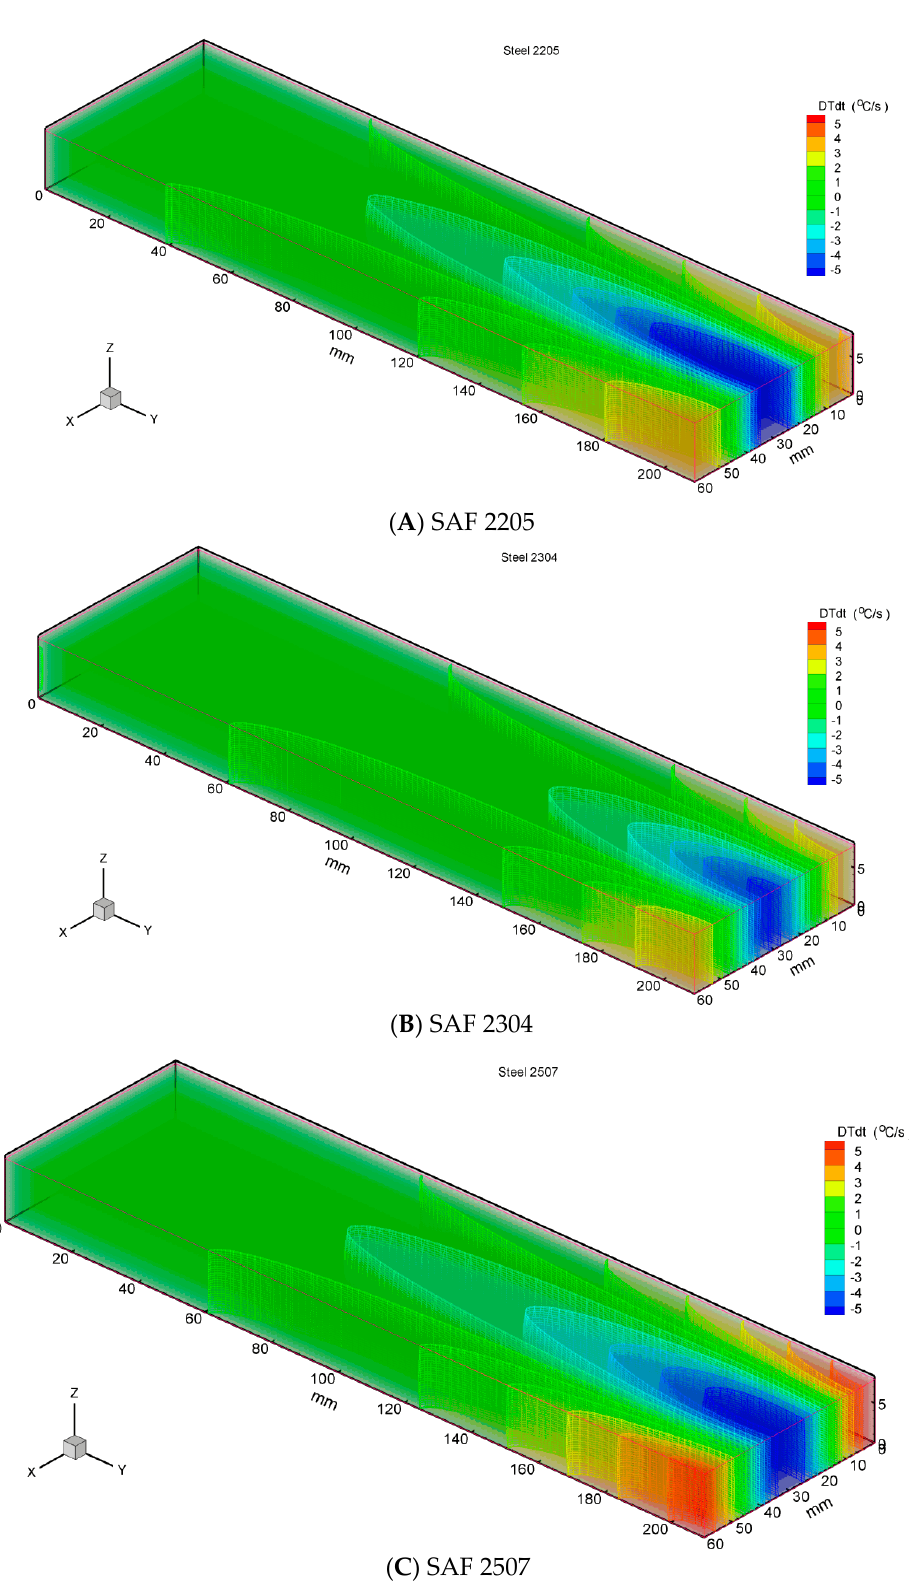
Figure 8. Heating/cooling rates distribution, ( A ) SAF 2205, ( B ) SAF 2304, and ( C ) SAF 2507 plates for the higher heat input at the end of the welding procedure.